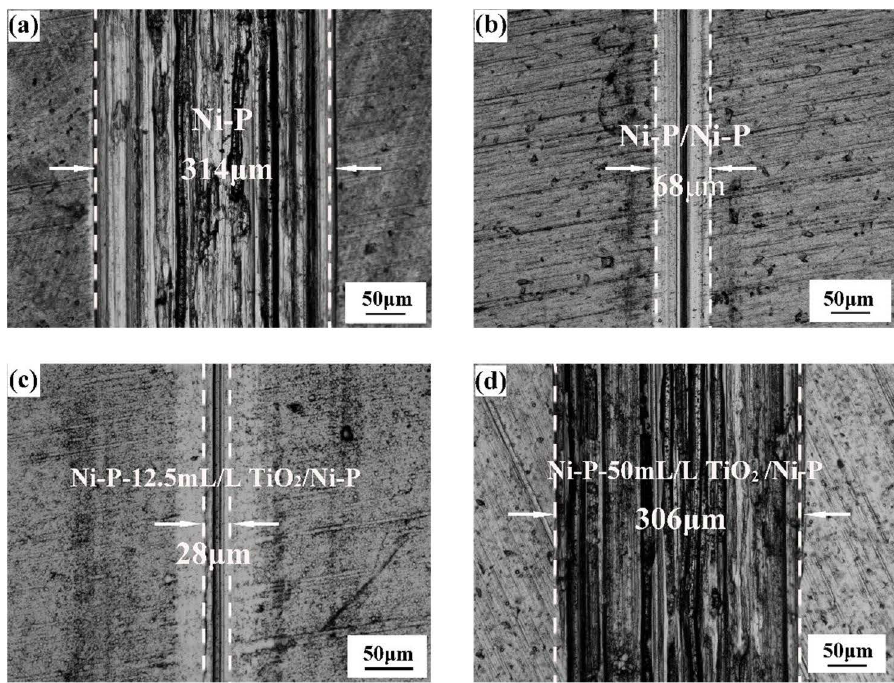
/Ni-P and (d) Ni-P-50mL/L TiO 2